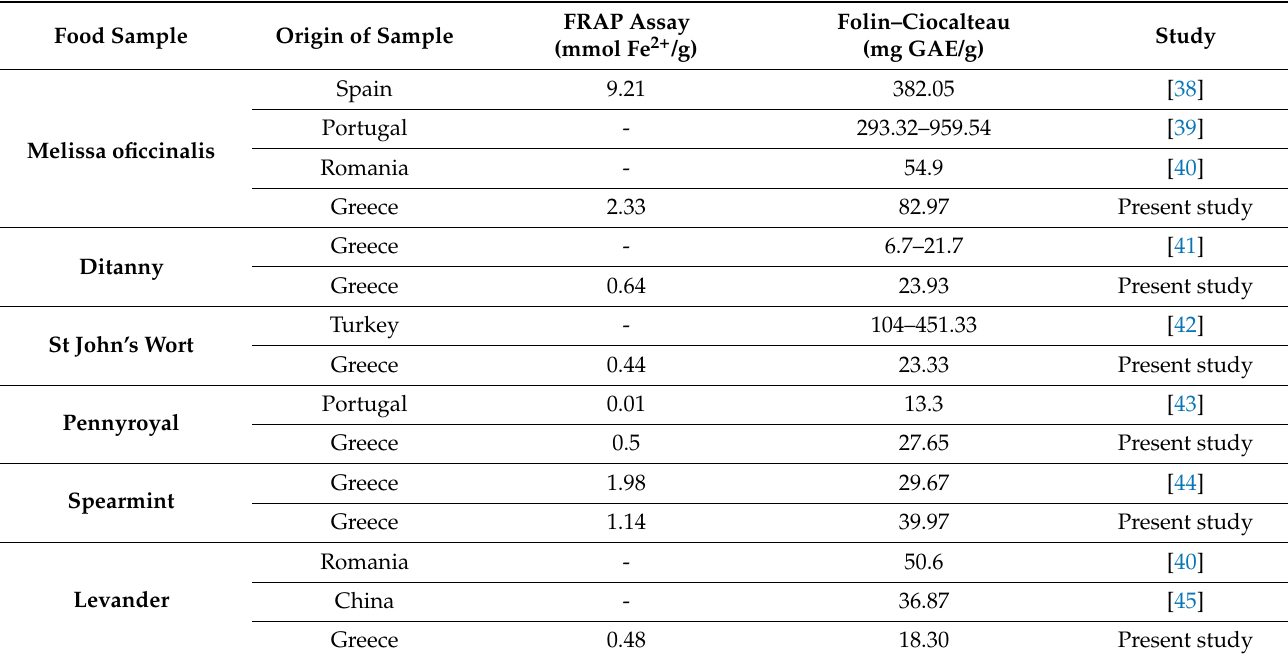
Table 2. Mean concentrations of total phenolic content and total antioxidant activity of selected herbs and byproducts reported in